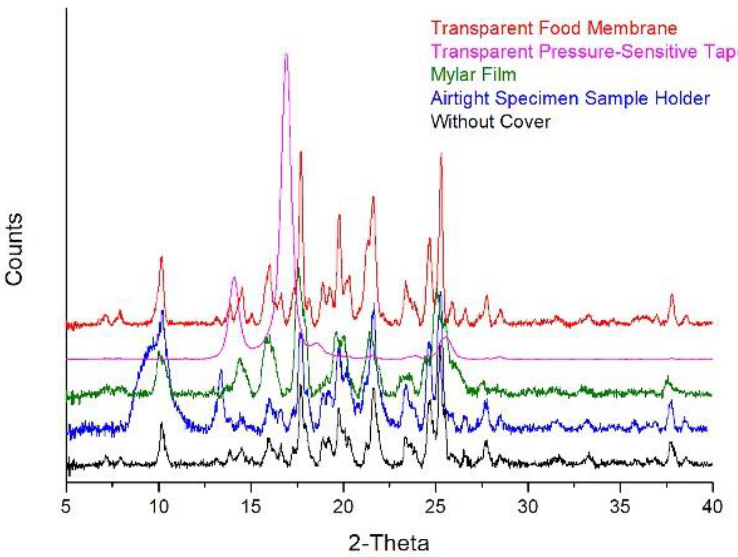
Figure 5. Sample-preparation methods for delaying polymorphic conversion of Posaconazole in the received precipitate after centrifuging Posaconazole oral suspension: XRPD patterns of Posaconazole precipitate without any cover ( black line ) and Posaconazole precipitates placed on an airtight specimen sample holder with dome-like X-ray transparent cap ( blue line ), on a PMMA sample holder covered with a Mylar film ( green line ), on a PMMA sample holder covered with transparent pressure-sensitive tape ( magenta line ) and on a PMMA sample holder enfolded with a transparent food membrane ( red line ).